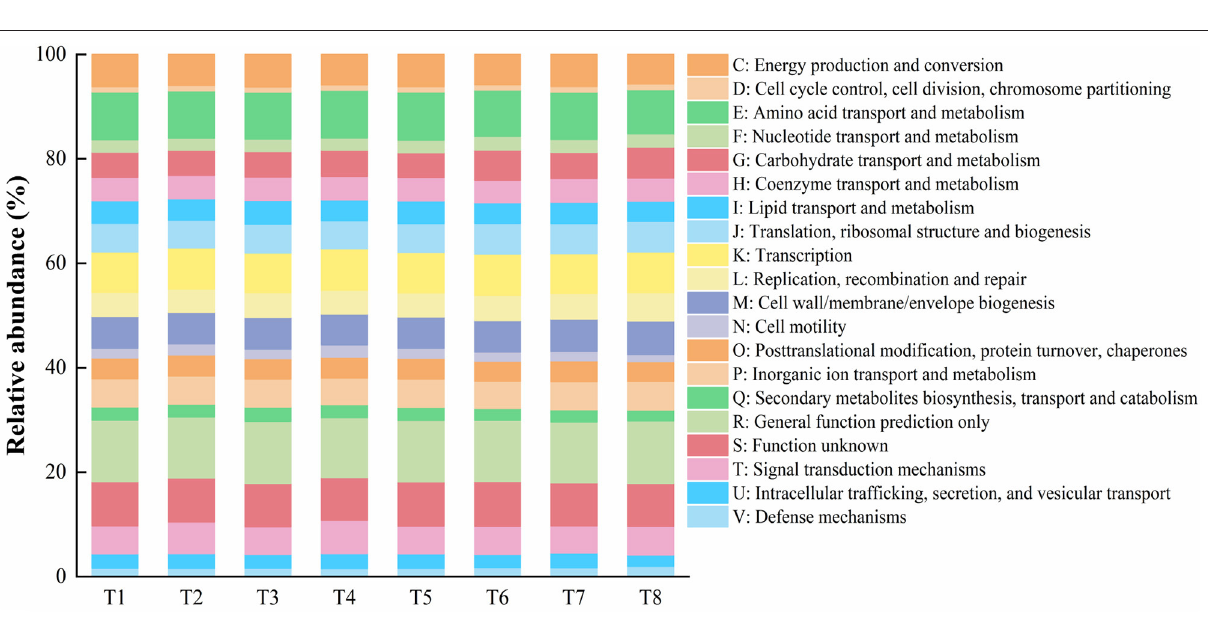
FIGURE 4 | Representing gut microbiota presumptive functions and their relative abundances of the mussel Mytilus coruscus in different experimental treatments. [T1 (DO 6mg L − 1 × pH 8.1 × 20 ◦ C), T2 (DO 6mg L − 1 × pH 8.1 × 30 ◦ C), T3 (DO 6mg L − 1 × pH 7.7 × 20 ◦ C), T4 (DO 6mg L − 1 × pH 7.7 × 30 ◦ C), T5 (DO 2mg L − 1